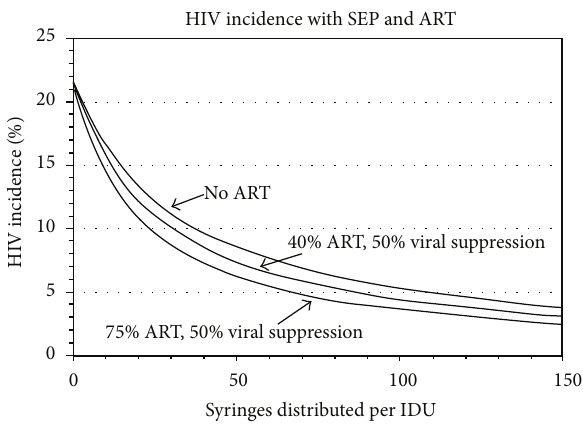
Figure1:ModelingofeffectsofsyringesdistributedandARTandon annual HIV incidence among PWID in Tallinn, Estonia. The impact on incidence of SEP combined with 2 levels of ART coverage (40% and 75%), assuming 50% of those on ART cannot contaminate a